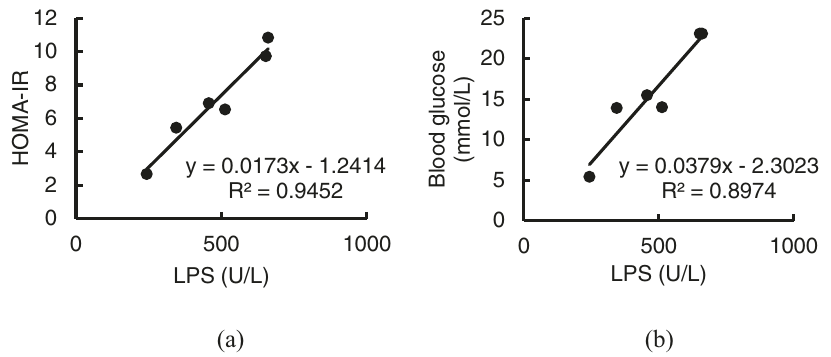
Fig. 9 Relevance between HOMA-IR or blood glucose and LPS. a HOMA-IR; b Blood glucose.